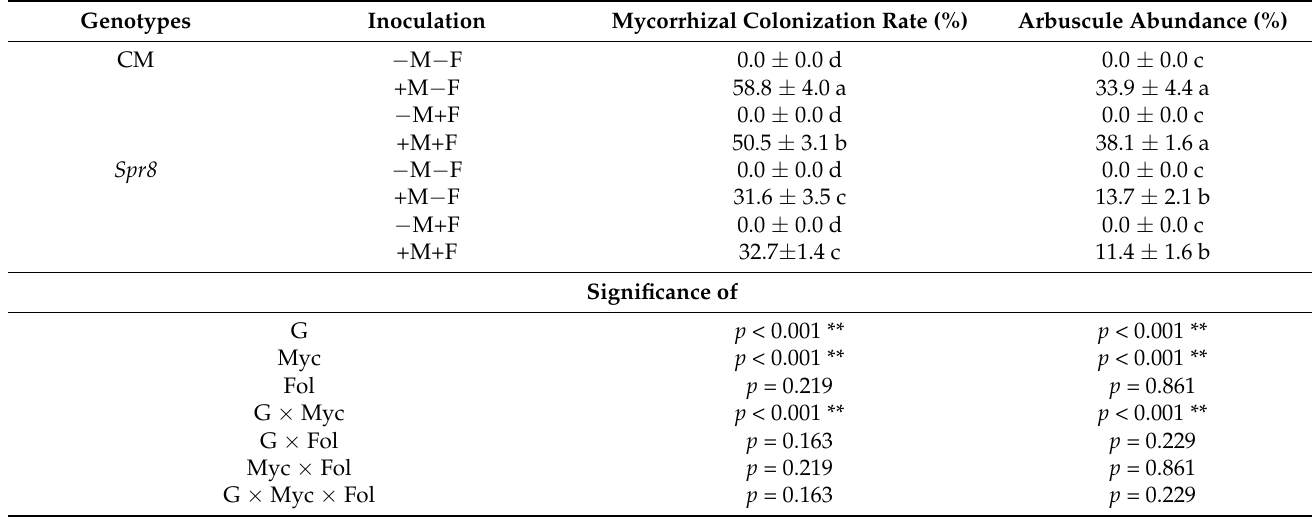
Table 1. Effects of inoculation with Rhizophagus irregularis inoculation (Myc) and Fusarium oxysporum f. sp. Lycopersici (Fol) on the mycorrhizal colonization rate and arbuscule abundance of CM and spr8 plants (G). − M and +M represent non-inoculation and inoculation with Rhizophagus irregularis , respectively. − F and +F represent non-inoculation and inoculation with Fusarium oxysporum f. sp. Lycopersici , respectively. Same lowercase letters after the values in the same column indicate non- significant difference ( p < 0.05) between corresponding treatments. *— p < 0.05; **— p <